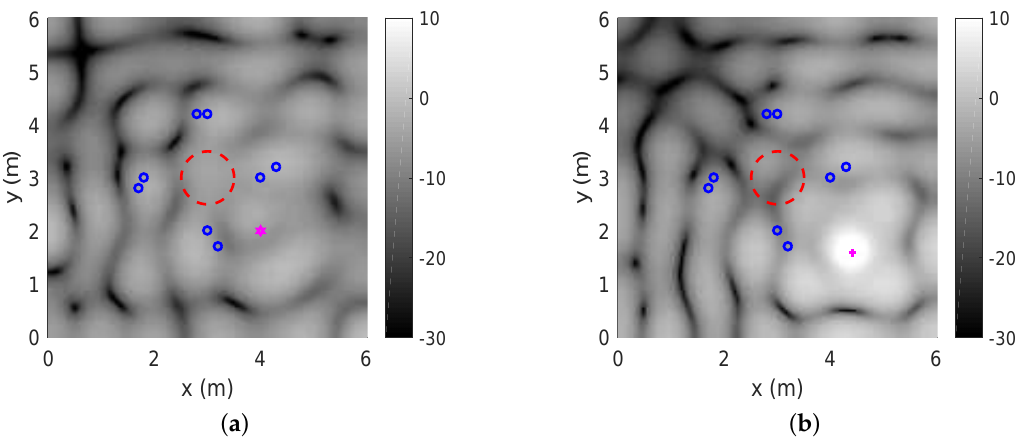
Figure 3. Energy of the primary noise field, where pink point is the projection of the primary source on the x-y plane, blue points are the loudspeaker points located on the x-y plane, and the red dashed circle is the boundary of the region of interest: ( a ) case 1; ( b ) case 2.